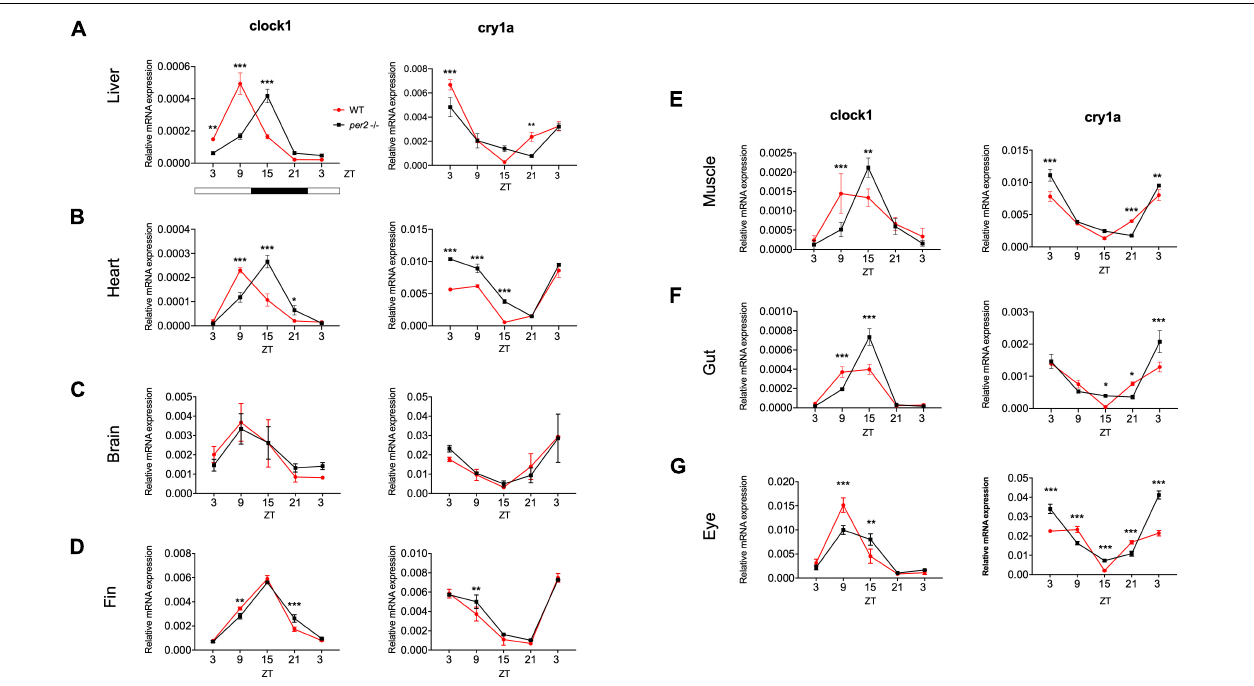
FIGURE 4 | Per2 knockout alters rhythmic mRNA expression of the cry1a and clock1 clock genes in adult zebrafish tissues. qRT-PCR analysis of expression levels of the circadian clock genes clock1 and cry1a in the (A) liver, (B) heart, (C) brain, (D) fin, (E) muscle, (F) gut and (G) eyes of WT and per2 mutant adult fish. Sets ( n = 3) of 4 WT and per2 KO fishes (each set containing two males and two females) were maintained under LD cycle (14 h light-10 h dark) conditions, tissues were dissected and pooled for RNA extraction at 6-h intervals during a sampling window of 24 h. Mean mRNA relative expression ± SD is plotted on the y -axis; zeitgeber time (ZT) is plotted on the x -axis. Zeitgeber times are indicated for each sample. ZT0 corresponds to lights-on, ZT14 to lights-off. A change in rhythm was observed for both genes in liver, heart, fin, muscle, gut, and eyes, as determined by a significant ANOVA Genotype × Time interaction effect ( p < 0.001, see Table 1 ). For both genes, no effect was observed in the brain. Asterisks represent levels of significance in comparing the two genotypes at each time point individually, corrected by Sidak’s method (*** p < 0.001, ** p < 0.01, * p <